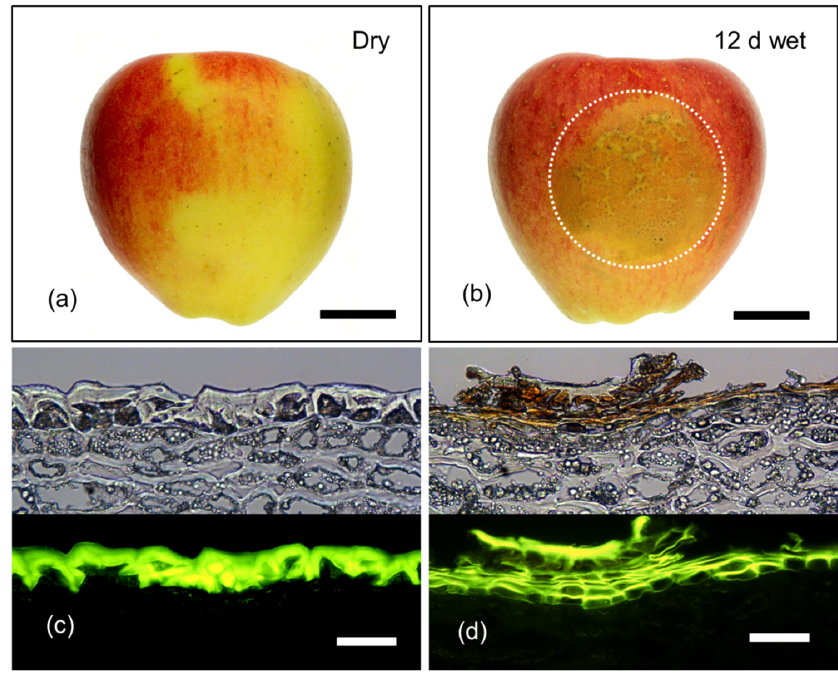
Figure 6. Macrographs ( a , b ) and micrographs ( c , d ) of mature (156 days after full bloom; DAFB) ‘Pinova’ apple fruit following exposure to surface moisture for 12 d at 31 DAFB (wet). Fruit without moisture-exposure, served as controls (dry). Micrographs represent cross-sections of the fruit skin in the moisture-exposed region and the dry region. Micrographs were taken under transmitted white light (upper) or incident fluorescent light (lower) (filter module U-MWB) after being stained with Fluorol Yellow 088. The area enclosed by the dotted circle represents the footprint of the moisture-treated patch of skin that subsequently developed russet. Scale bar in ( a ) and ( b ) is 2 cm long and that in ( c ) and ( d ) is 50 µm long.